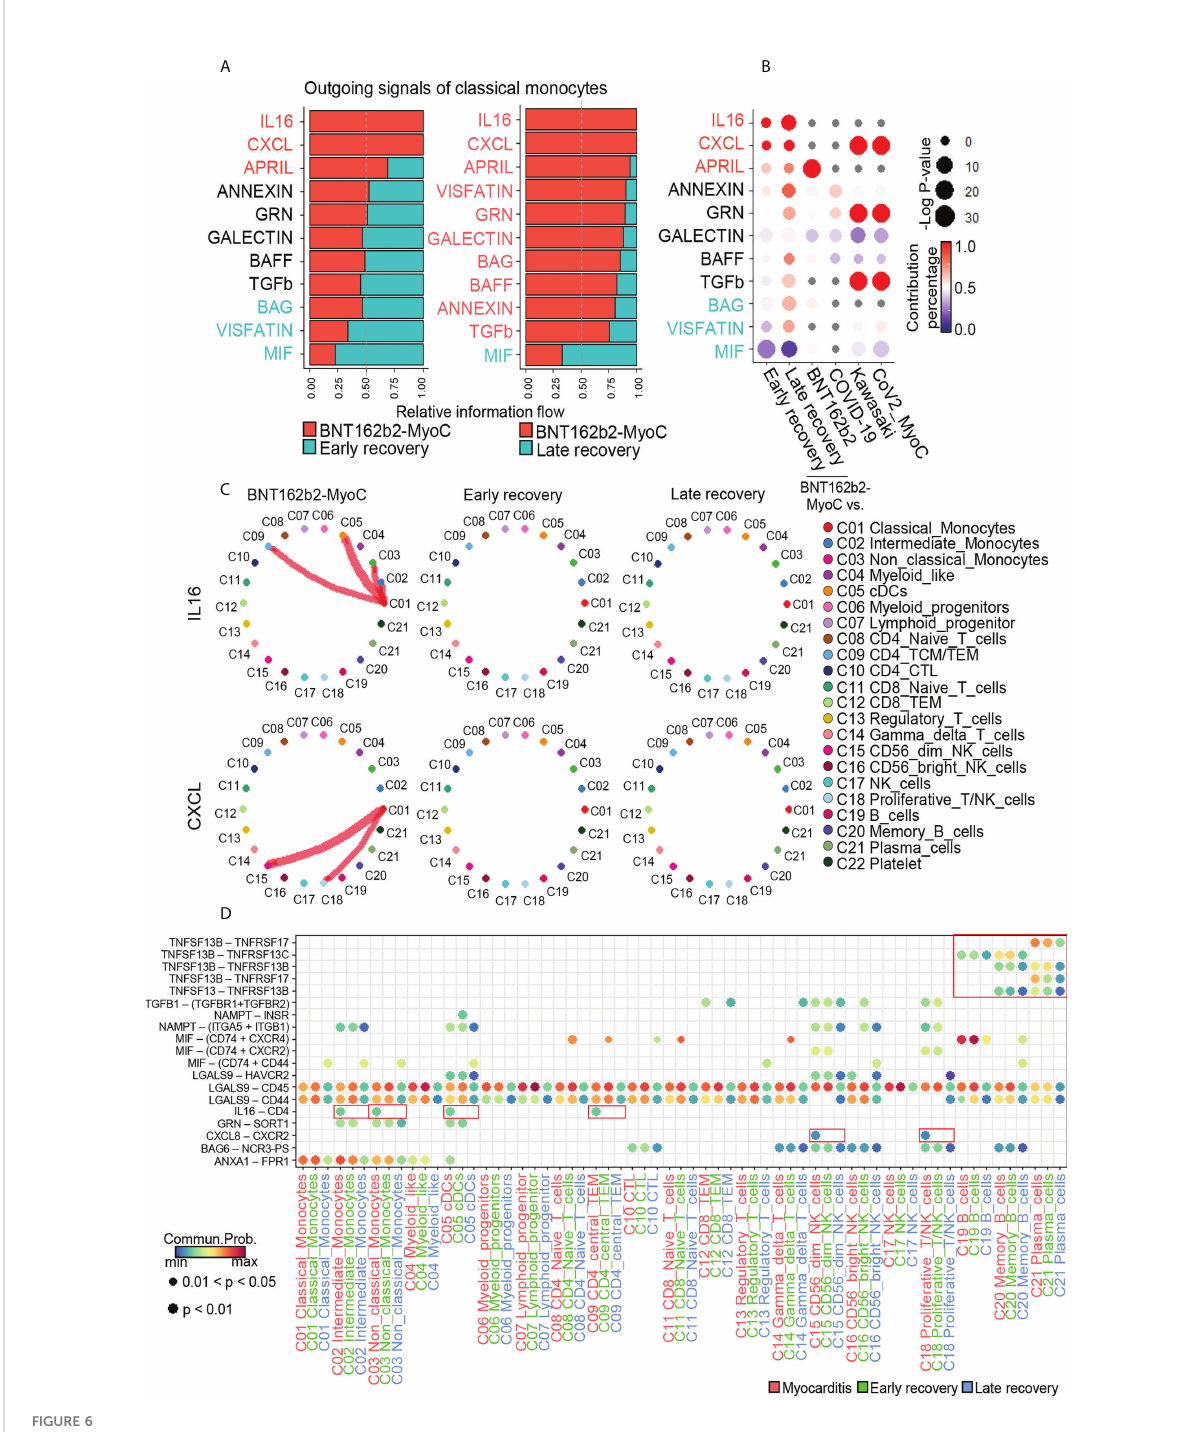
FIGURE 6 Classical monocytes-mediated IL-16 and CXCL signals were enhanced during BNT162B2-MyoC Stage. (A) Bar graphs showing the ranking of major outgoing signals of classical monocytes in the patients in BNT162B2-MyoC compared to early(left) and late(right) recovery stages, respectively. The rank of signals was based on differences in overall information fl ow of each group. (B) A dot plot showing signaling enrichment of classical monocytes in other datasets for the classical monocytes-speci fi c outgoing signals speci fi c in BNT162b2-MyoC stage. Grey dots indicate insigni fi cant interactions. (C) Circle plots showing cell-to-cell network for increased outgoing signals of classical monocyte in BNT162b2-MyoC stage. Arrows and edge color indicate direction (source: target). Edge thickness indicates the sum of weight key signals between populations. (D) A dot plot showing the relative signi fi cance of each cell type for each signaling pathway based on the average expression of the ligand-receptor